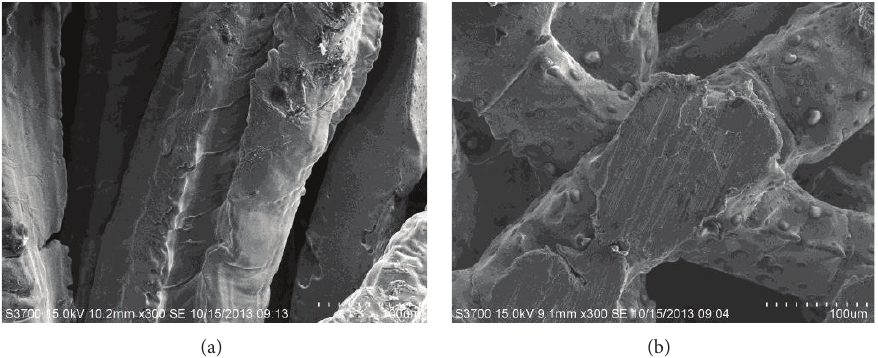
Figure 3: Surface morphologies of SSSFF sintered 60 min (a) at 1200 ∘ C and (b) at 1300 ∘ C.